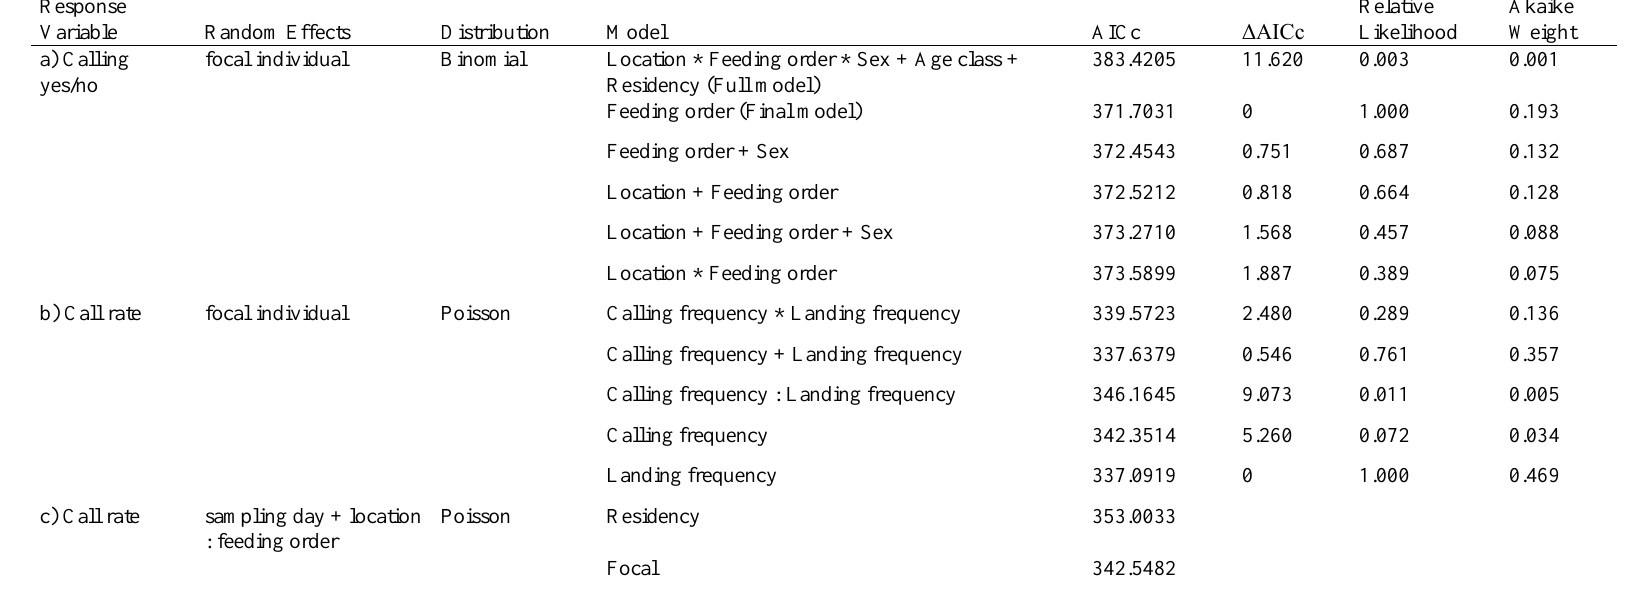
Model Ranking Based on Relative Likelihoods and Akaike Weights Calculated from ΔAICc Values for Response